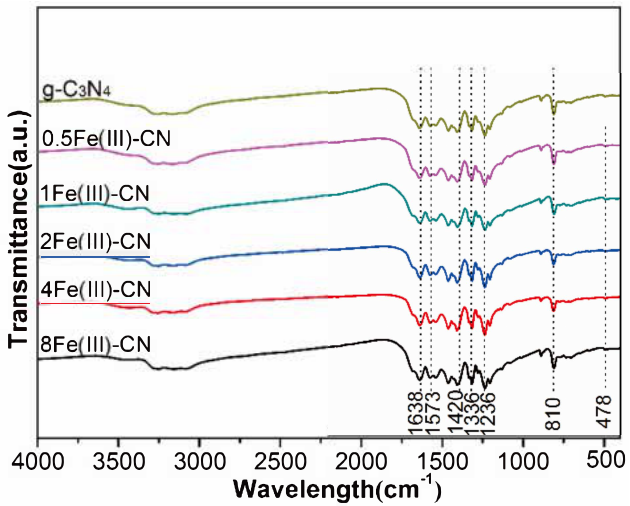
Figure 4. FT-IR spectrum of all samples.